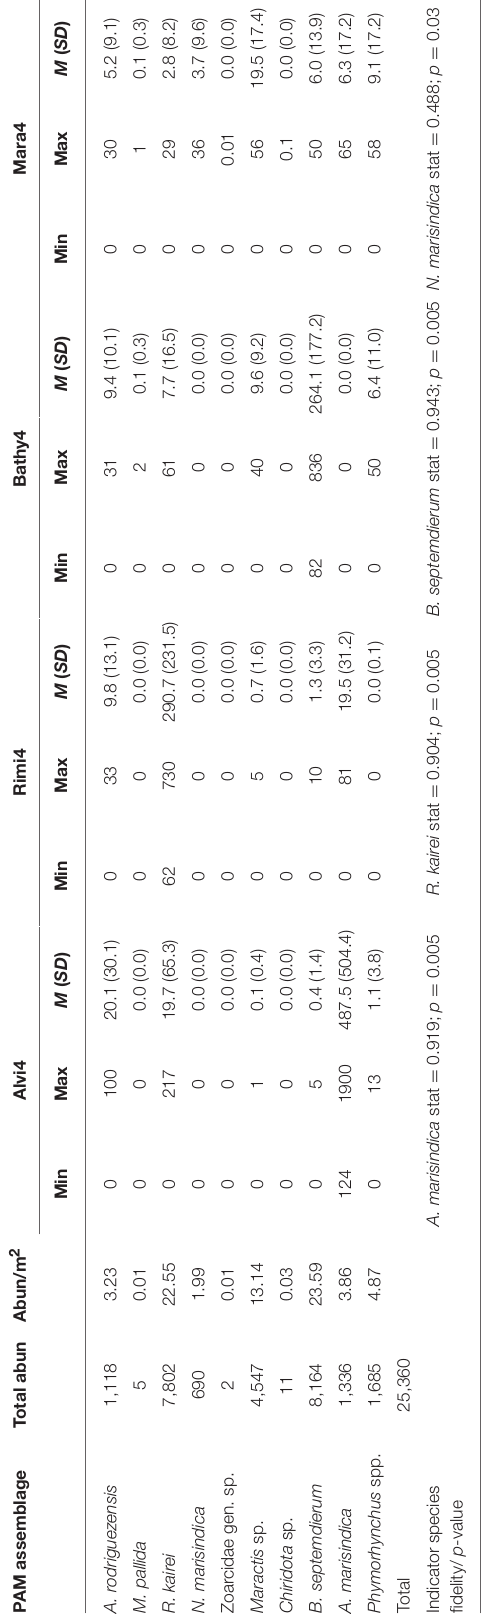
Mara7, Bathy7, MarPhy7, Bacteria7, and SulChim7. Species related to more than one faunal assemblage either occurred in close proximity to fluid exits throughout different assemblages or in certain distances to fluid exits, and often had varying abundances or individual sizes. The “pairwiseAdonis” comparison of each faunal assemblage could